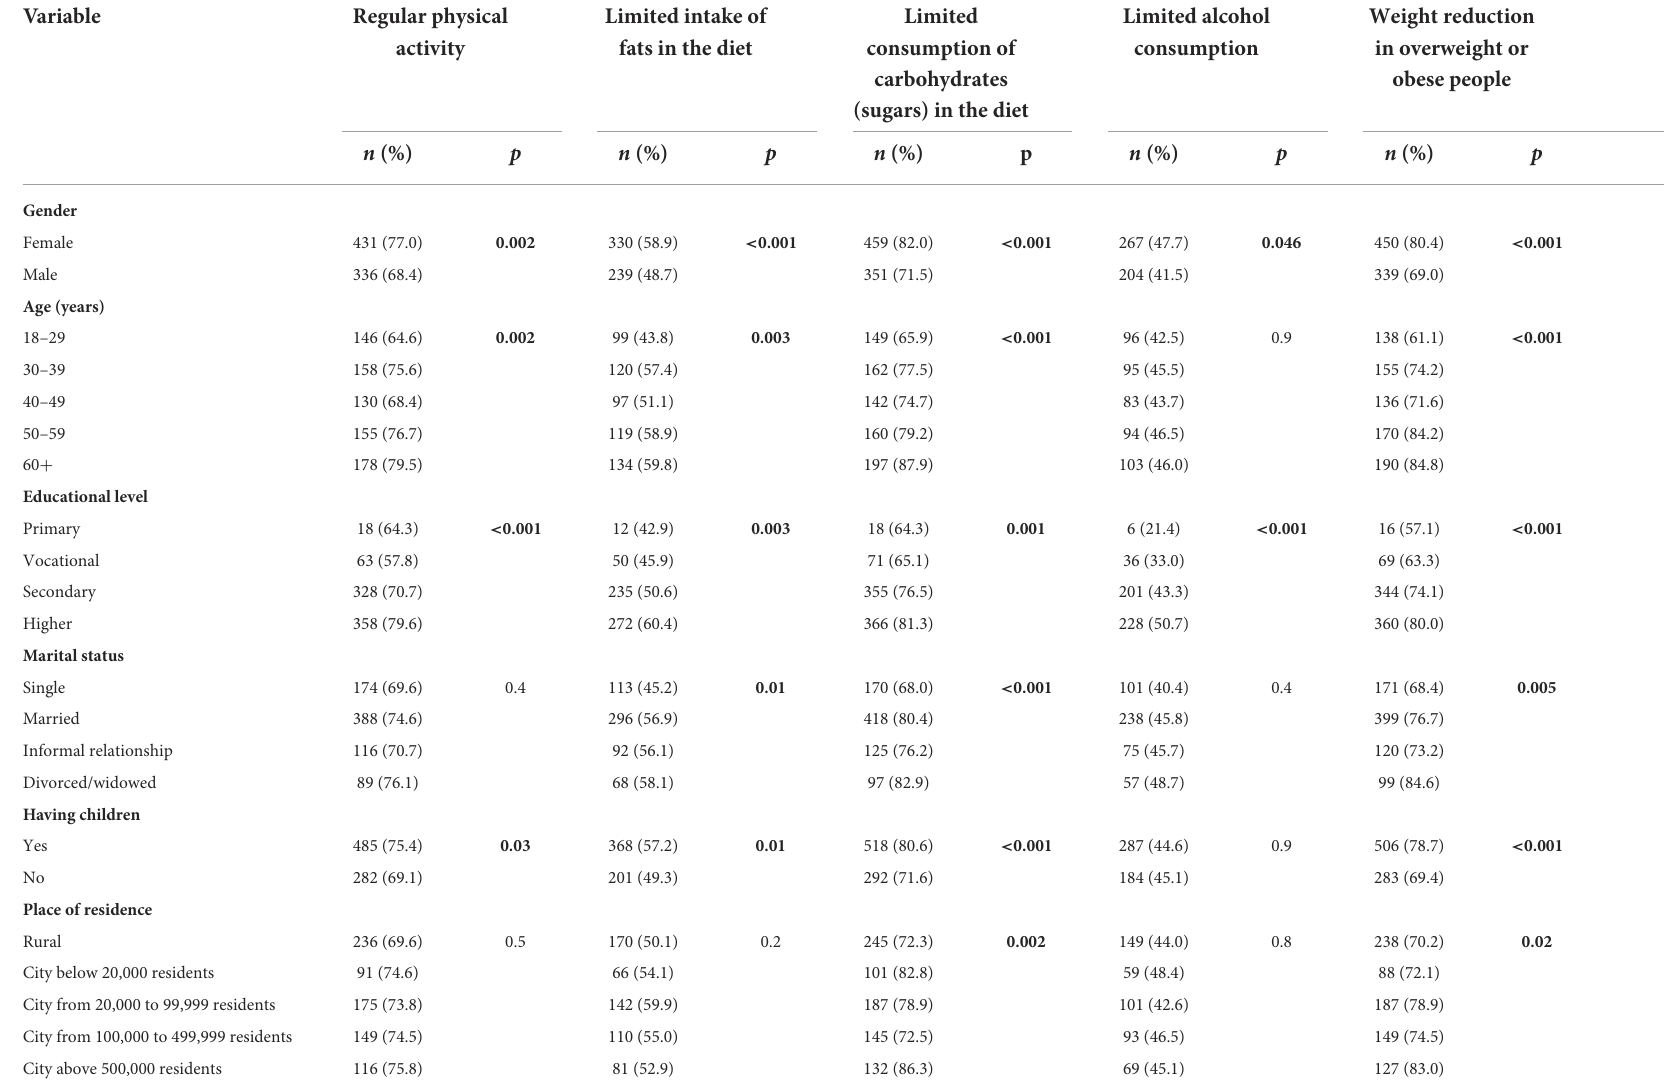
TABLE 6 Awareness of diabetes prevention methods by sociodemographic factors ( n = 1,051). Diabetes prevention methods - percentage of respondents who answered “yes” by sociodemographic